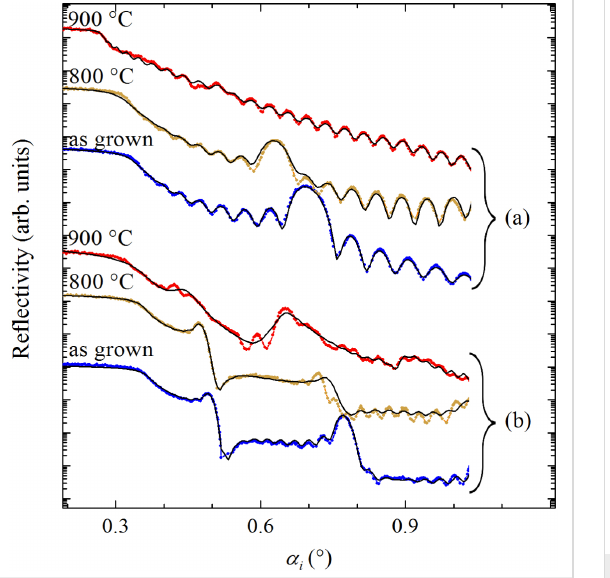
Figure 2: XRR curves of as-grown and annealed (Ta–N+Al 2 O 3 )/Al 2 O 3 multilayers for two different nominal thicknesses of the metallic layers: (a) 4 nm and (b) 12 nm. The curves are vertically shifted for clarity.